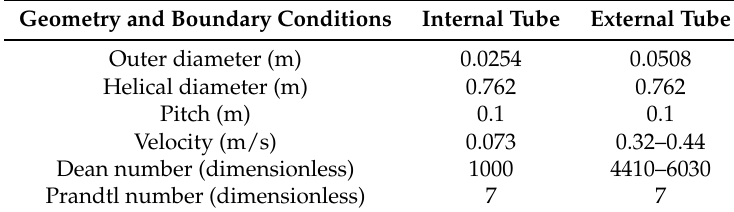
Table 1. Geometry and boundary